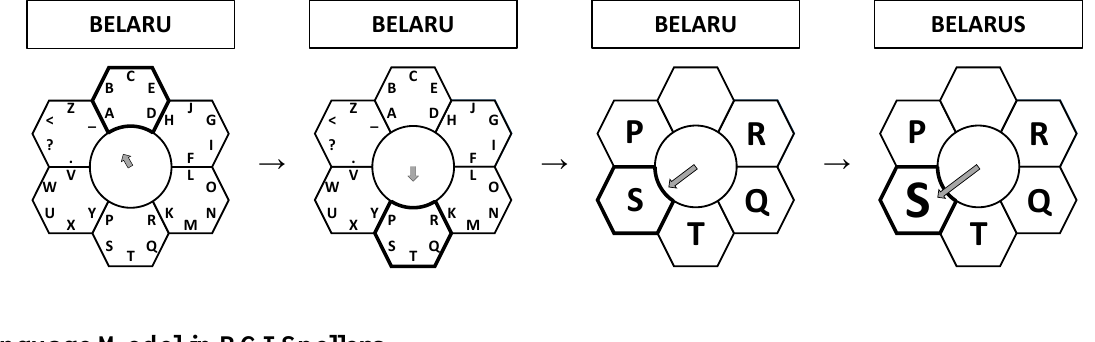
Figure 4. Two different types of imaginary movements allow the user to control the rotation and extension of the gray arrow in the Hex-o-Spell interface. In this example the last letter in the word ―BELARUS‖ is selected. Adapted from